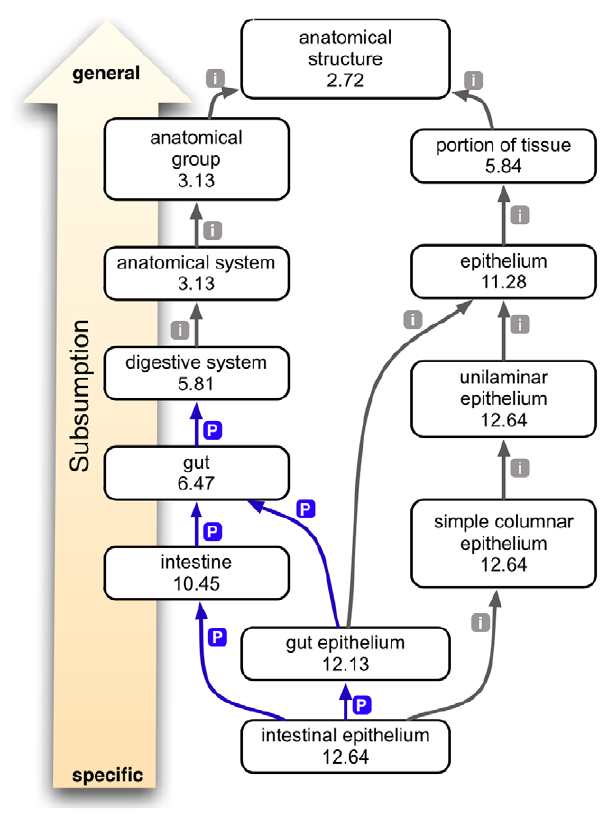
Figure 3. Ontology subsumption reasoning. This example from Washington et al. [23] shows the relationships of the term ‘‘intestinal epithelium’’ to other anatomical entities within the ZFA ontology. Gray arrows with an ‘‘i’’ indicate an is-a relation, and blue arrows with a ‘‘p’’ indicate a part-of relation. The numbers indicate IC of the node, which is the negative log of the probability of that description being used to annotate a gene, allele, or genotype (collectively called a feature). As terms get more general, reading from bottom to top, they have a lower IC score because the more general terms subsume the annotations made to more specific terms.